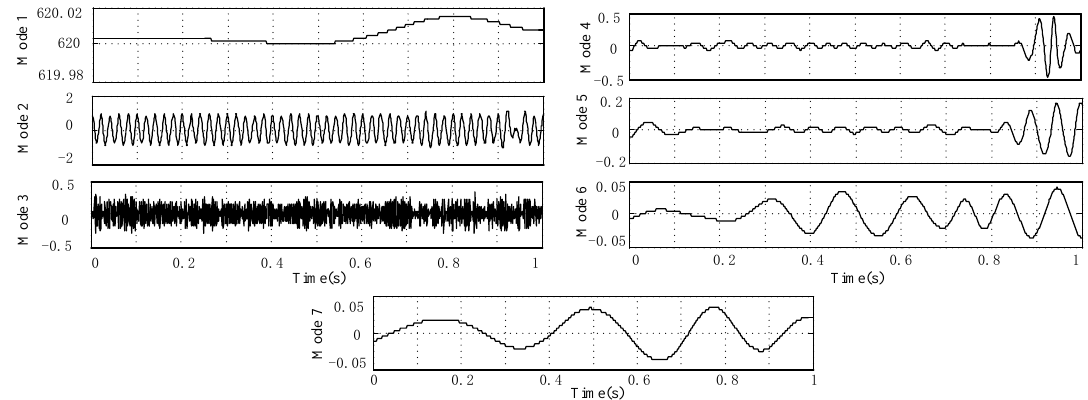
Figure 23. The decomposed modes of EMD algorithm.